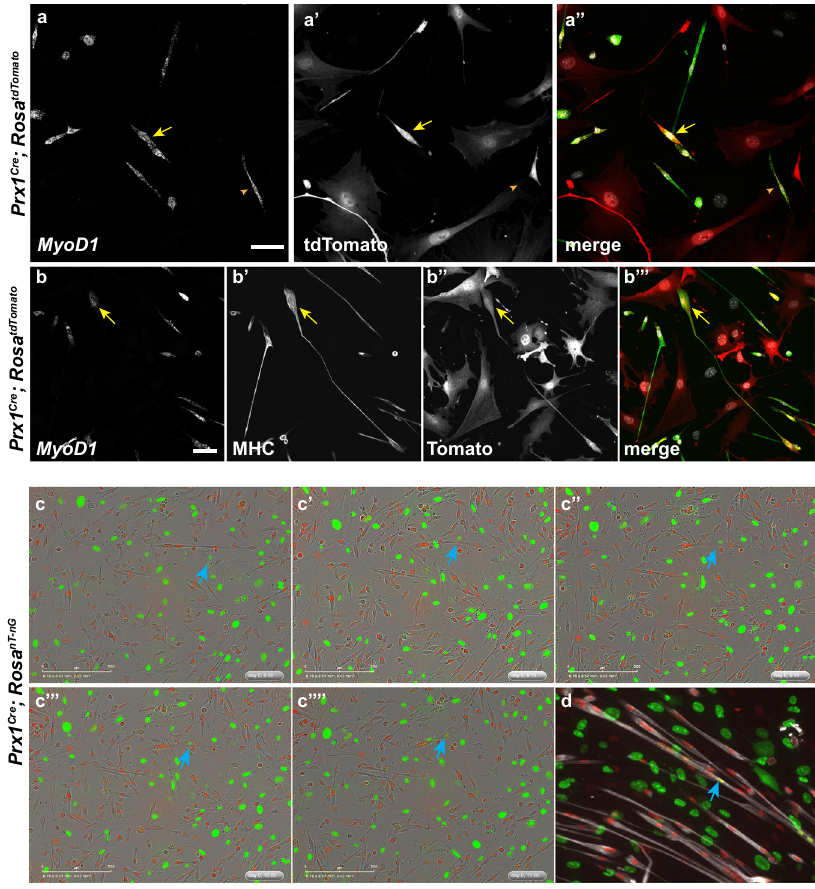
Fig. 3 Cultured muscle interstitial cells fuse into growing myotubes. Primary culture of myoblasts and interstitial cells derived from Prx1 Cre ; Rosa tdTomato following 24 h of differentiation demonstrates the presence of tdTomato expressing MyoD1 (yellow) and MHC (green) expressing myo fi bers ( a , b ). Snapshots of live-cell imaging of Prx1 Cre ; Rosa nt-ng -derived primary culture after 48 h in differentiation media revealing fusion of fi broblast (blue arrow) into growing myo fi ber ( c - c ″ “ ). Following 72 h in differentiation media, fi bers marked by MHC (gray) with multiple fusion events are observed ( d blue arrows). Shown are representative images of FISH and immunostaining results of at least three independent cell isolation experiments from the distinct genotypes. Scale bar in a , b = 50 µ m and in c = 200 µ